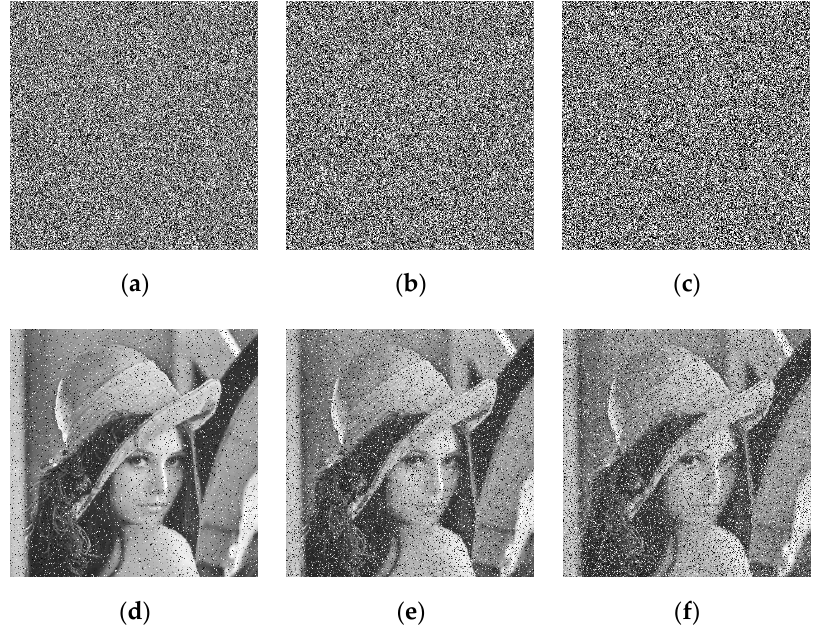
Figure 15. The ciphered images added by different levels of noises and the related decrypted images: ( a ) the ciphered image with noise intensity 0.1; ( b ) the ciphered image with noise intensity 0.2; ( c ) the ciphered image with noise intensity 0.3; ( d ) the decrypted image with noise intensity 0.1; ( e ) the decrypted image with noise intensity 0.2 and ( f ) the decrypted image with noise intensity 0.3.